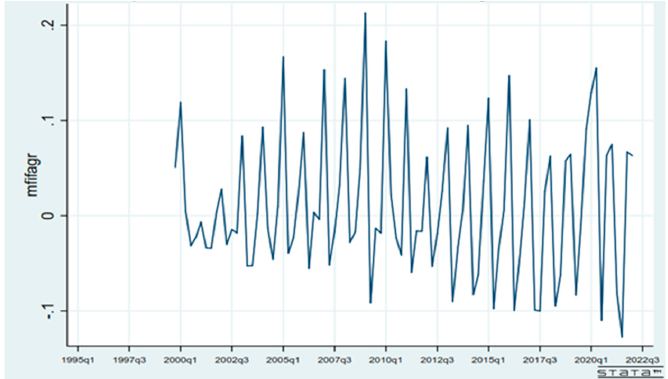
Figure A3. Monetary & Financial Institutions Financial Assets Grooth Rate in Greece. J. Risk Financial Manag. 2022 , 15 , x FOR PEER REVIEW